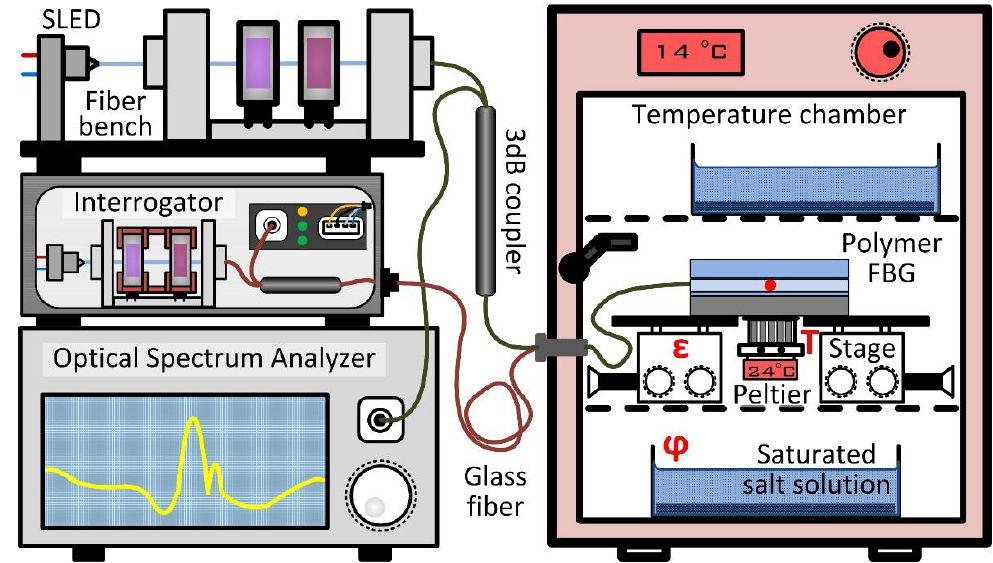
Figure 3. Schematic experimental setup of the investigations carried out for this work. For the polarization study, the light of the superluminescent diode (SLED) is manually readjusted in the fiber bench and guided via the coupler to the sample located inside the temperature chamber. The back reflection is evaluated using the optical spectrum analyzer (OSA). For strain characterization the interrogator with the internal light source, a depolarization unit, coupler, and spectrometer are utilized, and additionally three spectra are captured with the OSA. The sample is positioned on two translation stages, with which the tensile force is applied. The interrogator is also used for temperature measurement, where the sample is located on the Peltier element inside the temperature chamber. To characterize the sensitivity to humidity, various saturated salt solutions are placed in the temperature cabinet. The sample is again evaluated with the interrogator. Note FBG = fiber Bragg gratings.